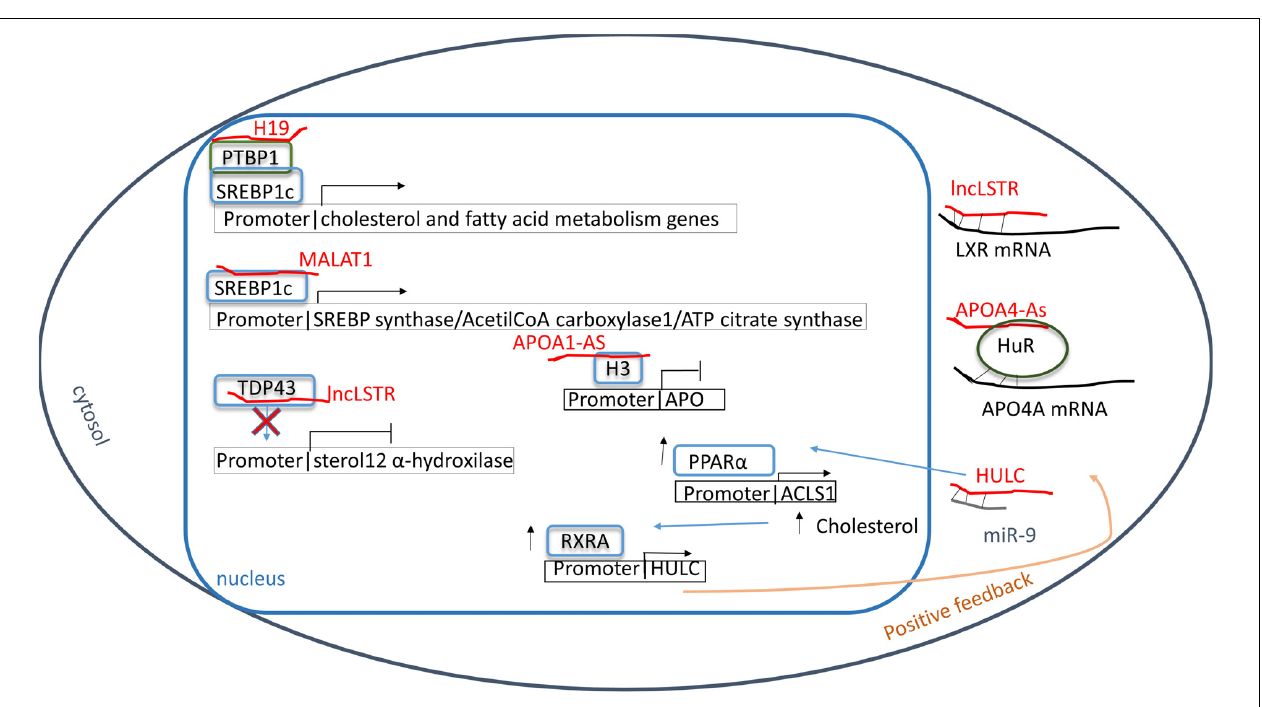
FIGURE 2 | Lipid metabolism. Red: lncRNA; green: proteins; blue: transcriptional factors; gray: miRNAs. Sterol regulatory element binding protein 1c (SREBP1c) can be modulated in different ways: directly binding MALAT1 or by poly-pyrimidine tract-binding protein 1 (PTBP1) that, in turn, binds H19. As result genes involved in lipid anabolism are expressed. The long non-coding RNA lncLSTR inhibits TAR DNA-binding protein 43 (TDP-43) blocking the transcription of sterol 12 α hydroxylase and increasing the hyperlipidemia. Moreover, the hyperlipidemia is enhanced by the inhibition of APO synthesis through the chromatin condensation at APO promoters by the hypomethylation condition of histone 3 at lysine 4 and 27 due to APOA1-As bound. In addition, farnesoid X receptor (LXR) and APOA4 mRNAs are inhibited by lncLSTR and HuR protein helped by APOA4-As respectively reducing the clearance of plasmatic fatty acids. In hypercholesteremia a positive feedback has been shown in which HULC enhances PPAR α synthesis. One effect is the increasing of retinoic acid X-receptor alpha (RXRA) level which recognizes and positively regulates HULC